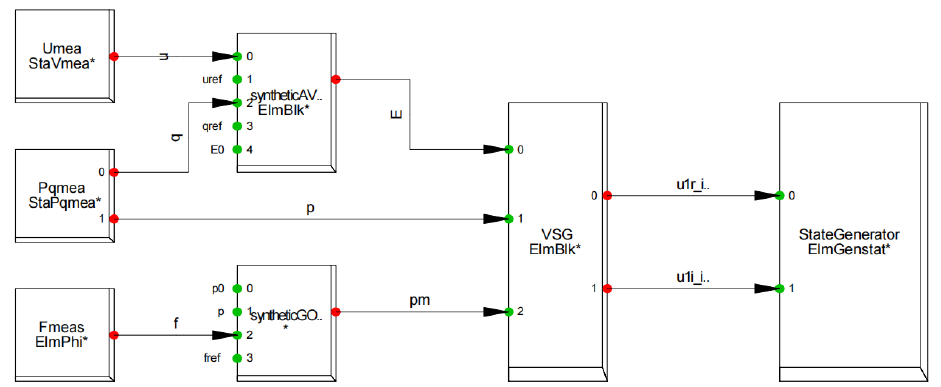
Figure 11. Implementation of VSG model based on DIgSILENT. Table 1. Node parameter settings.